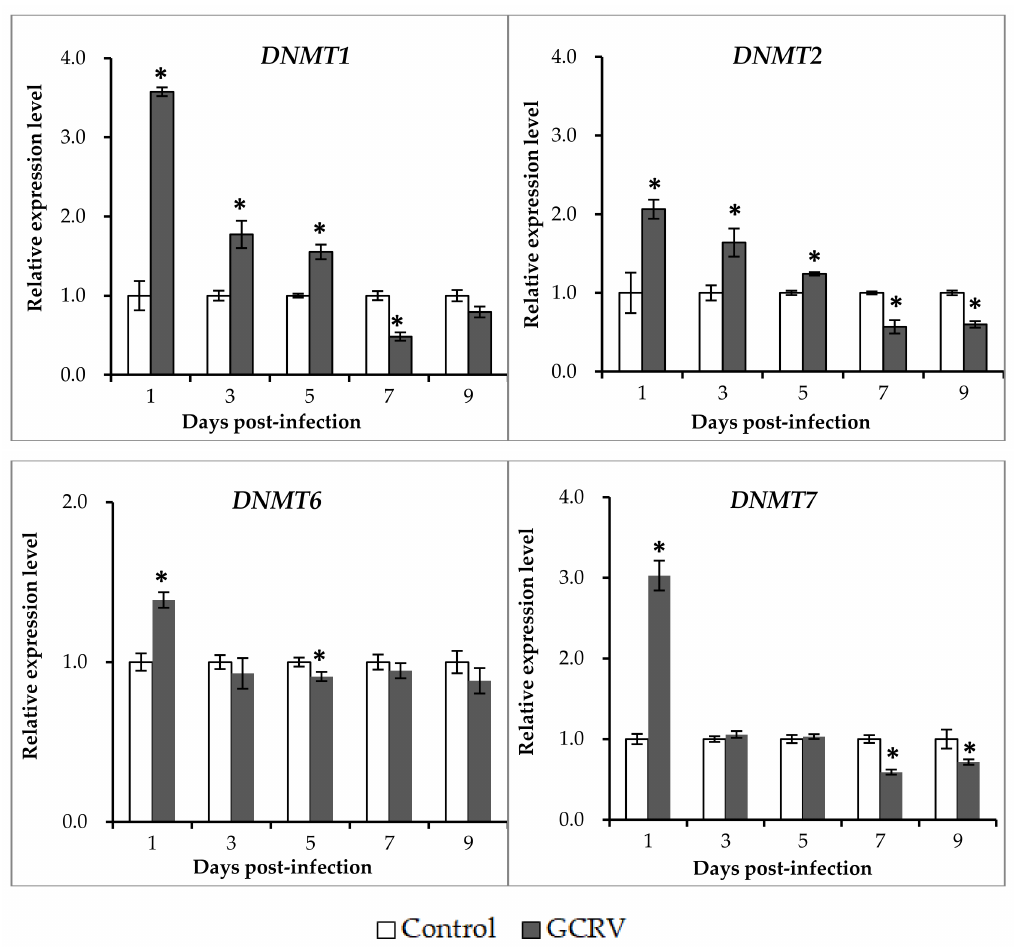
Figure 3. qRT-PCR analysis of the expression levels of DNA methyltransferases ( DNMT s) after GCRV infection. The relative expression levels of genes were calculated as the ratio of gene expression levels in the GCRV-infected group relative to those in the control group at the same time points. All data represent the mean ± standard deviation of three replicates ( n = 5 for each biological duplicate). Significant difference ( p < 0.05) in gene expression levels between the two groups are indicated with an asterisk